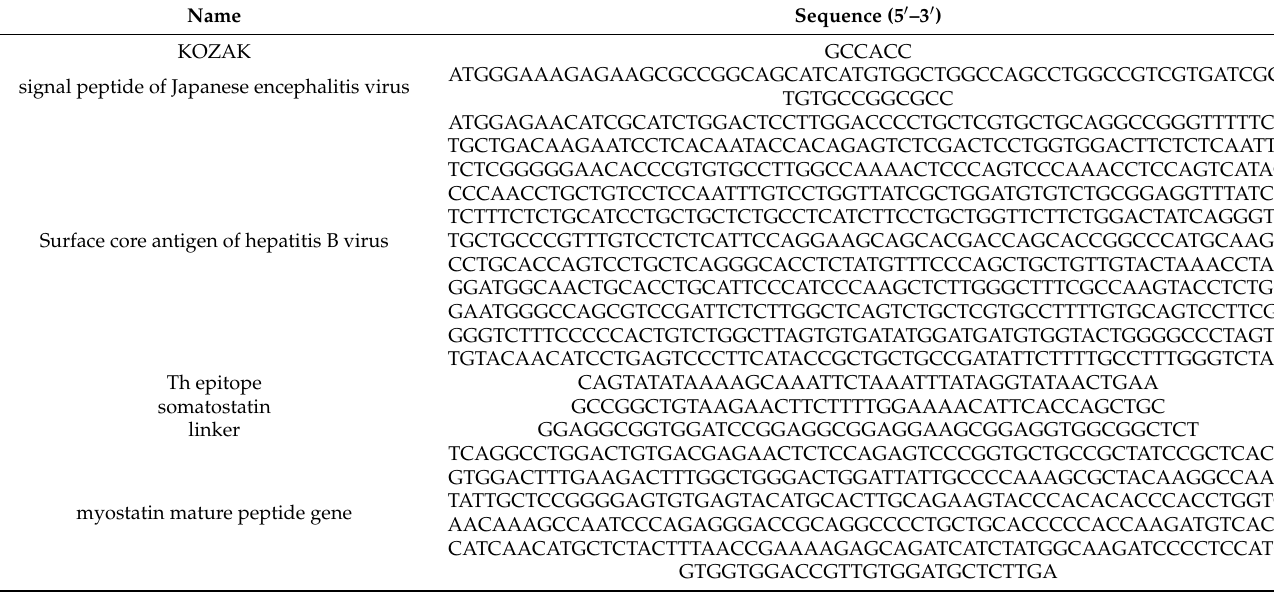
Table 1. Gene sequence used to construct nucleic acid